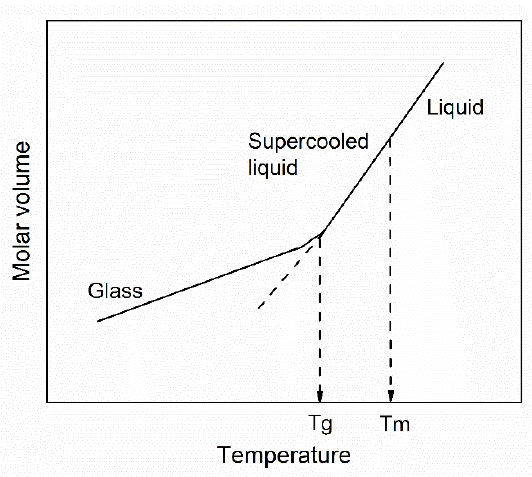
Figure 1. Schematic representation of molar volume as a function of the temperature of a glass liquid